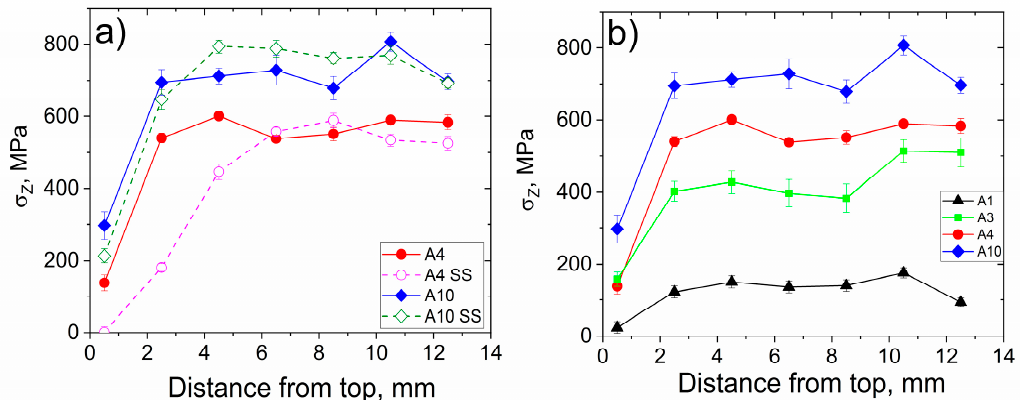
Figure 7. RS along the building direction for samples ( a ) with and without support structure (SS); ( b ) velocity variation.